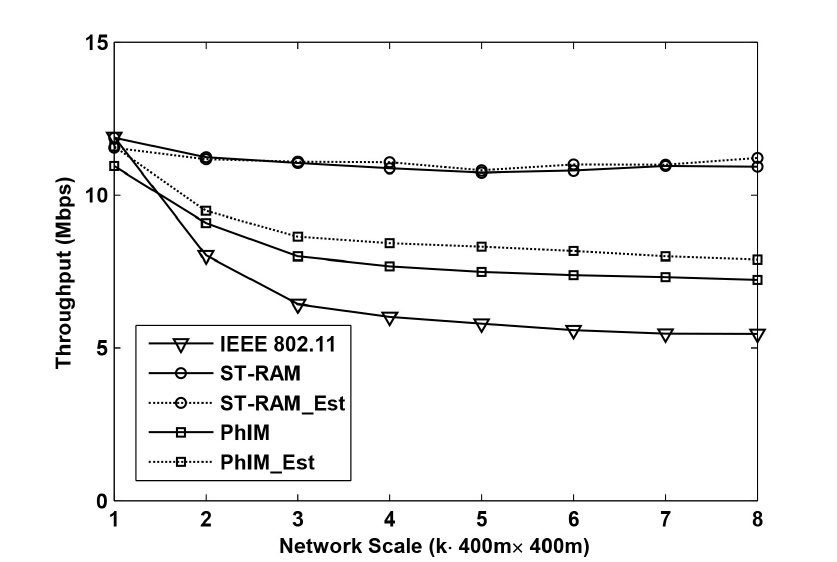
Figure 4. Throughput performance of different data collection methods for random deployed networks with different